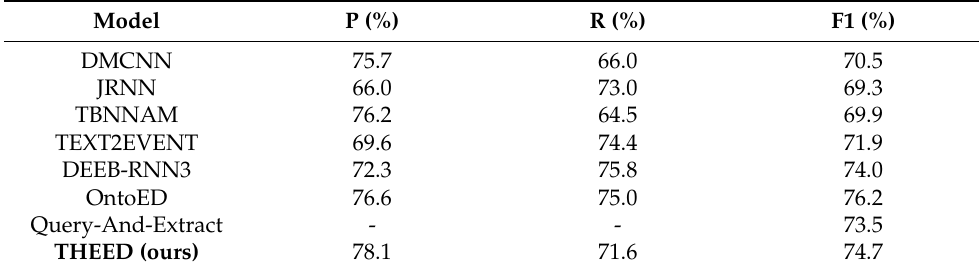
Table 4. Experimental results of event detection on ACE2005